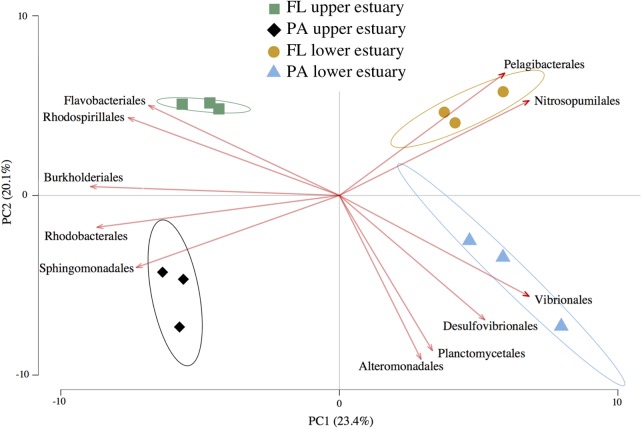
Euclidean distance PCA with feature biplots of taxonomic community structure. Plotted data are relative abundance of 16S OTUs grouped at Order-level taxa. Sample triplicates per habitat (points) are plotted alongside a set of the most important Orders driving sample separation (vectors). Arrow direction and magnitude represent both the covariance between features (Orders) and their effect on PC loadings. Ellipses represent 95% confidence intervals for centroid positions. FL, free-living; PA, particle-attached.